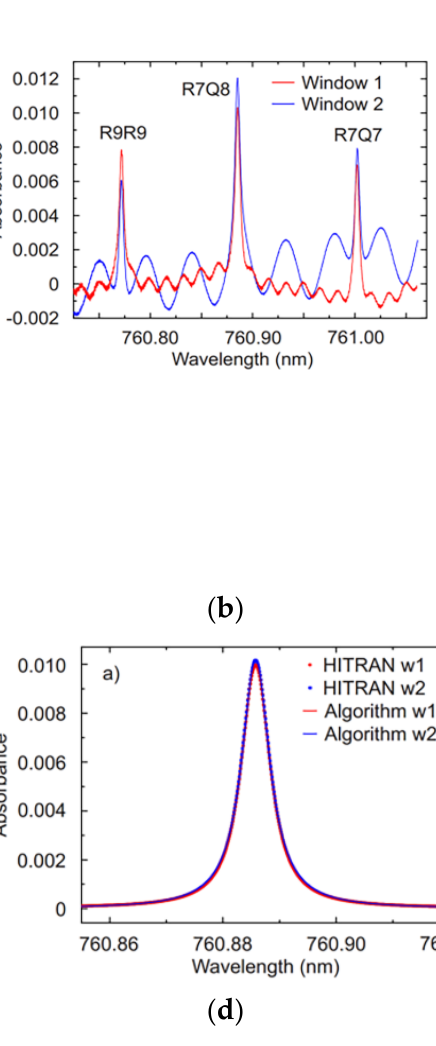
Figure 10. ( a ) Tukey window; ( b ) deliberately made interference fringe, ( c ) algorithm flowchart, ( d ) experimental result, ( e ) detail of the processed signal. This figure was adapted from [36].